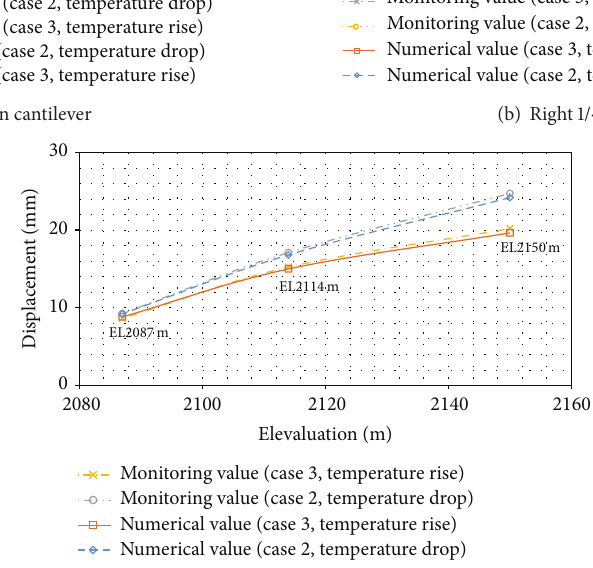
Figure 5: Numerical and field survey results of dam displacement in the direction along